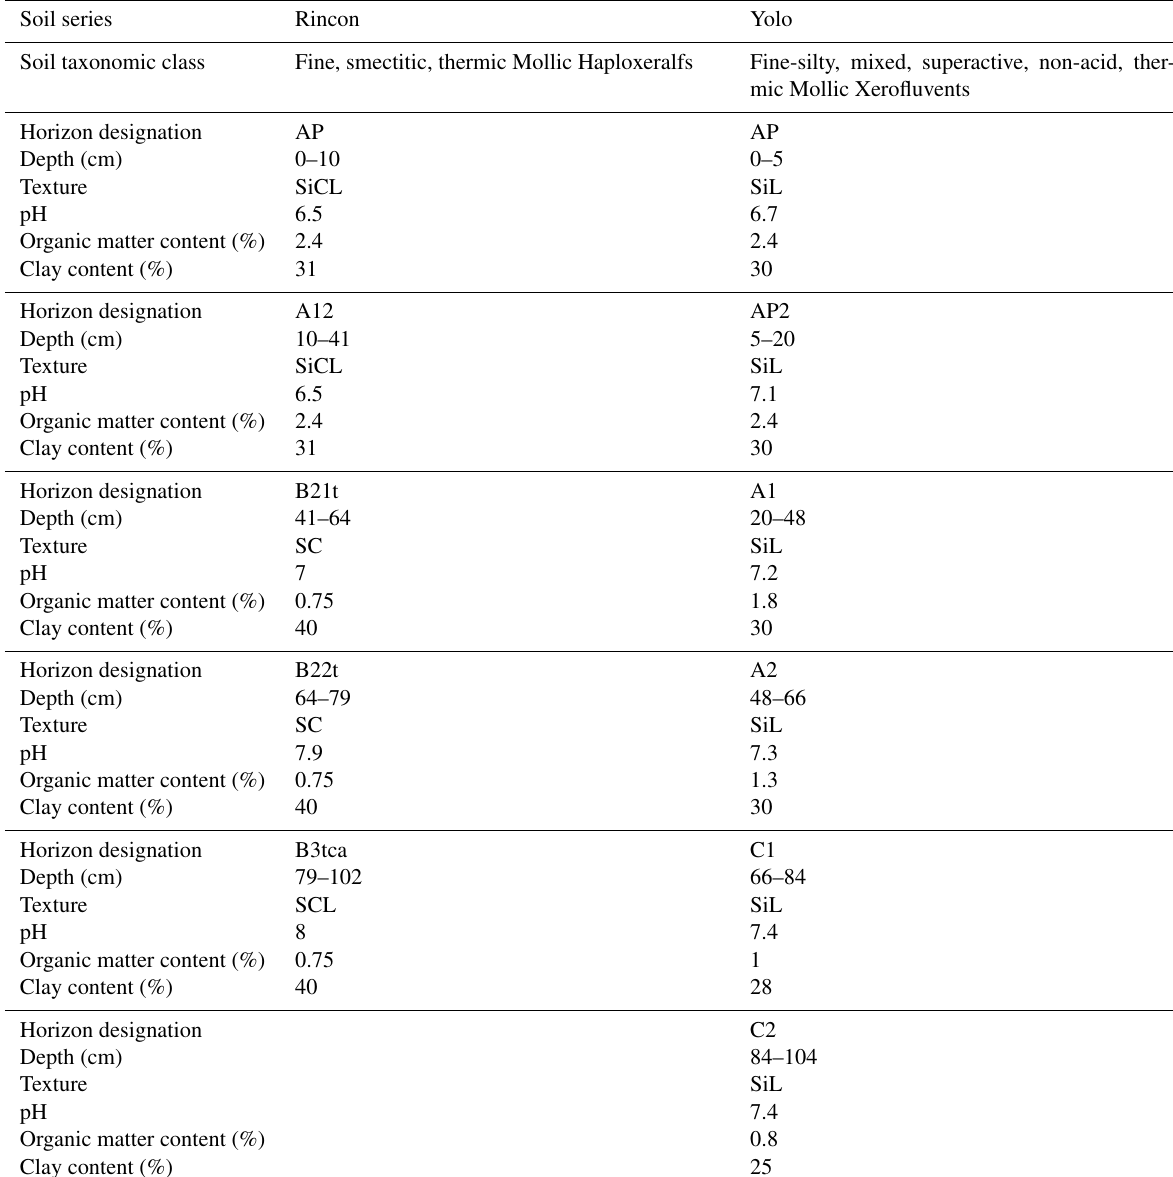
Table A3. Texture, pH, OM, and clay content for the Rincon and Yolo soil series found at Russell Ranch. Soil series Rincon Yolo Soil taxonomic class Fine, smectitic, thermic Mollic Haploxeralfs Fine-silty, mixed, superactive, non-acid, ther- mic Mollic